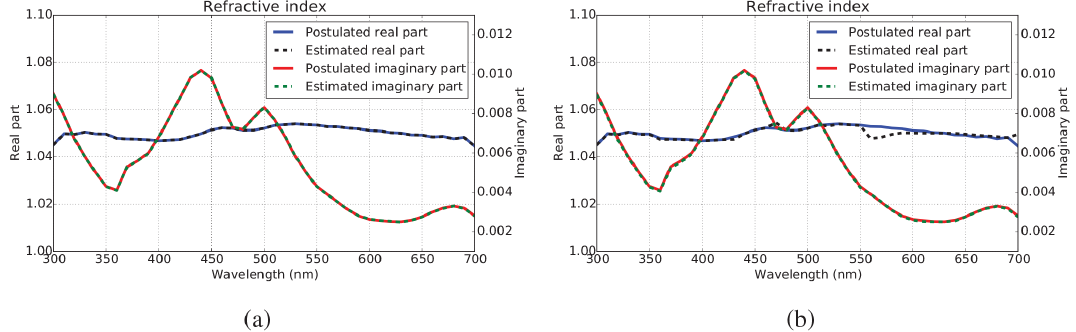
Figure 7. (a) Postulated and estimated refractive indices using the genetic algorithm; notice that the postulated and estimated values lie on top of each other. (b) Postulated and estimated refractive indices using the BFGS